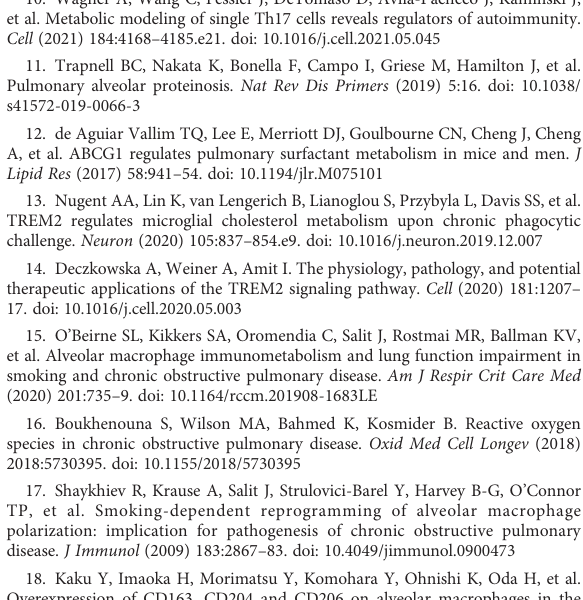
SUPPLEMENTARY FIGURE 5 Investigation of cell-to-cell interactions to infer important signaling pathways in macrophages (related to ). (A) Dot plot representation of monocyte-like macrophage-dependent ligand-receptor interactions predicted by CellPhoneDB that show signi fi cant enrichment (represented by the p-value) of the interacting pair in the interacting cell types either in COPD or in the control. Depicted are only selected interactions. (B, C) Illustration of the selection of potential upstream ligands of monocyte-like macrophages or C1Q+ macrophages based on the NicheNet analysis. The histograms show distributions based on ligand activity derived from the area under the precision recall curve (AUPR, upper histogram) and the Pearson correlation coef fi cient (PCC, lower histogram). The ligand activity of the highest ranked ligands is displayed in a color code together with the names of the 20 highest ranked ligands. The ligands predicted by the CellPhoneDB analysis (according to Figure S5A) are highlighted in red and thetop3 ligandsbasedonAUPR foreither monocyte-like macrophagesor C1Q+ macrophages (as presented in ) are underlined. (D) Expression of ligand targets from in macrophage subsets comparing COPD and control patients (z-transformed by gene). AUPR = area under the precision recall curve; PCC = Pearson correlation coef fi cient; M Ф = macrophage; DC = dendritic cell.